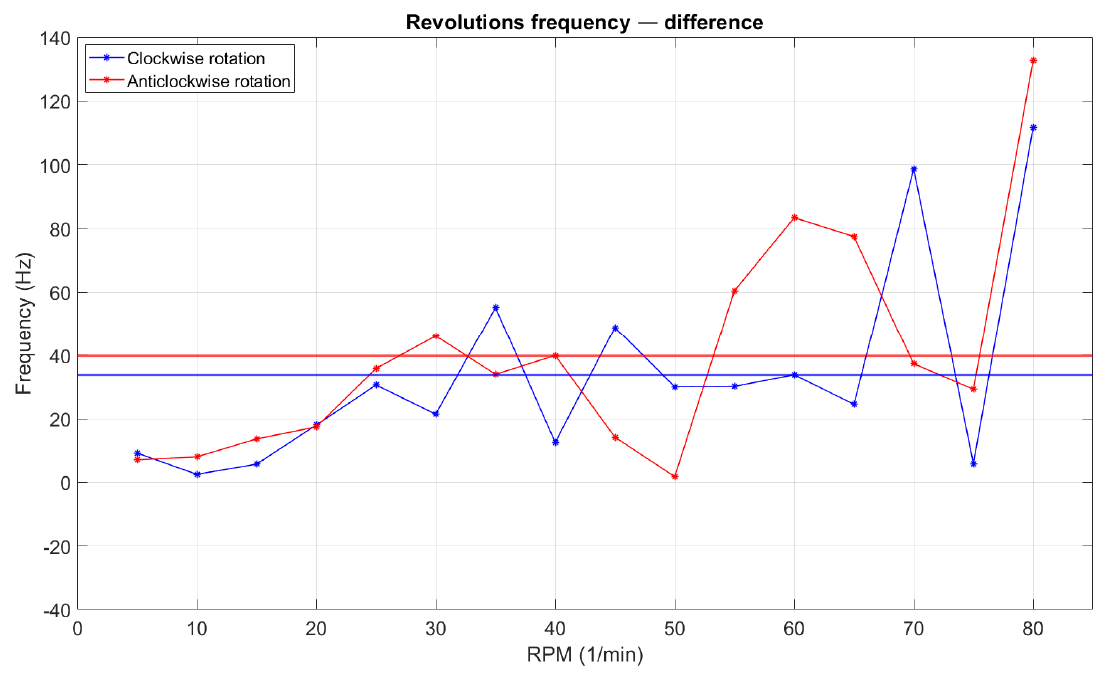
Figure 14. Plots with polyline of absolute value of the difference between encoder and oscilloscope values; straight line shows value of absolute error. Table 3. Values of absolute and relative error; oscilloscope was used as a reference.